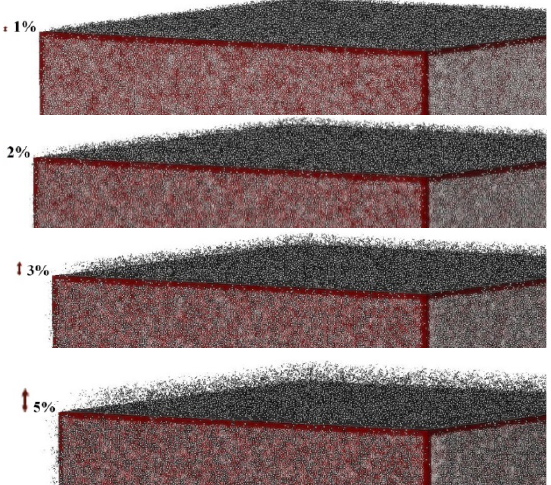
Figure 10. A close view of the synthetic (noisy) cube used for the experiments. From top to bottom, the standard deviation of the random noise corresponds to the 1%, 2%, 3%, 5% of the object edge length (20 cm).